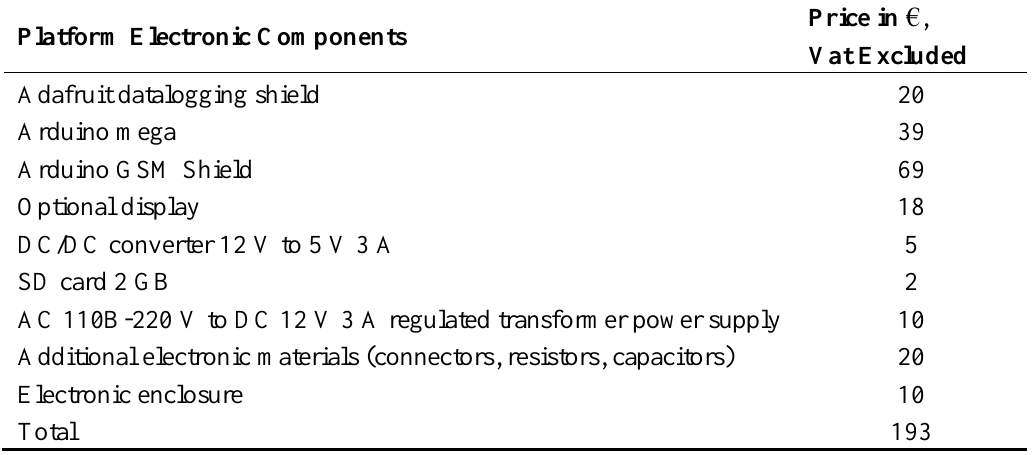
Table 1. Prices of the main components of the platform (source [53]).